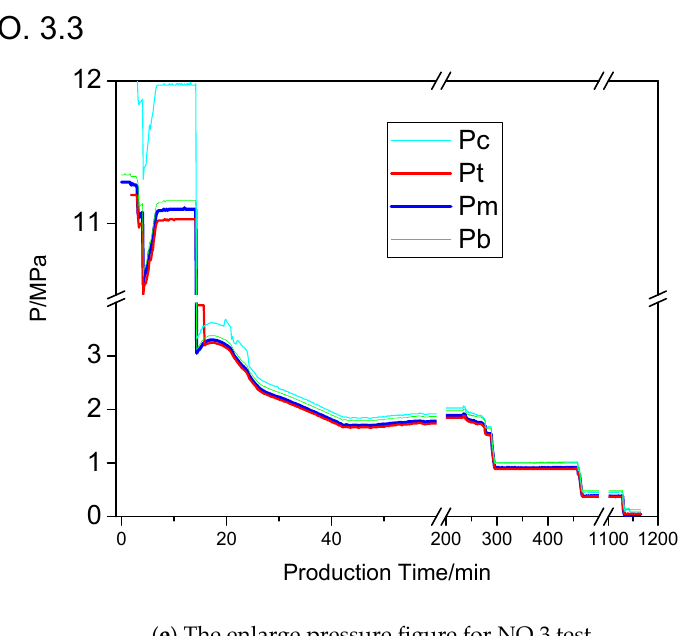
( e ) The enlarge pressure figure for NO.3 test Figure 4. Pressure, temperature, flow rate, and subsidence rate. (TH, TL, and TM indicate the mean temperature and standard deviation in the top, bottom, and middle layers; Φ s indicates the sand rates in produced water; Pc, Pt, Pm, and Pb indicate crustal pressure, top layer pore pressure, middle layer pore pressure, and bottom layer pore pressure).